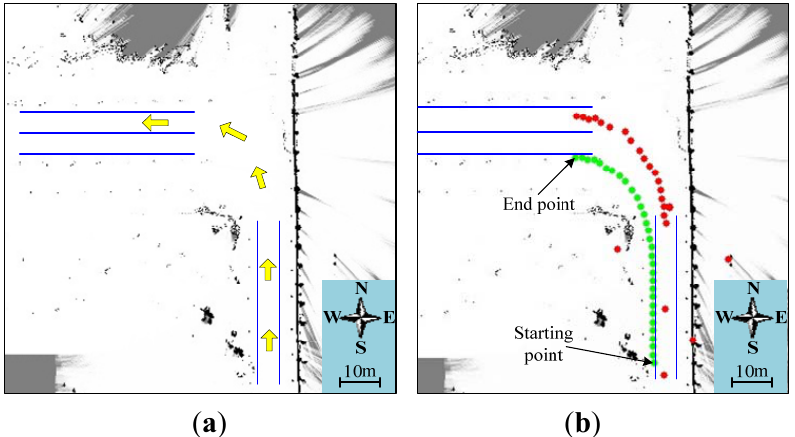
( b ) Localization results of odometer (green points) and the window constraint Markov localization (WCML) method (red points).